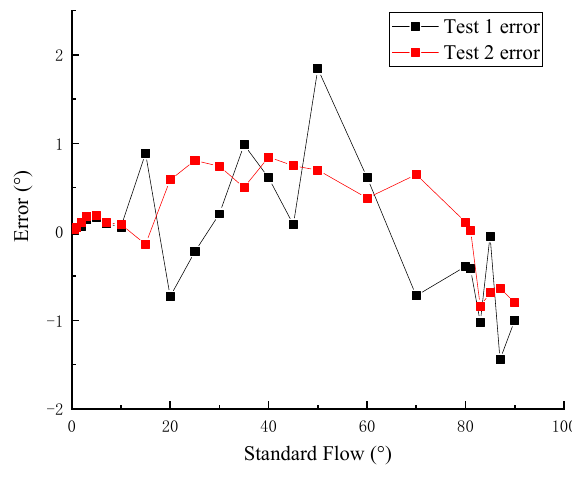
Figure 22. The error.